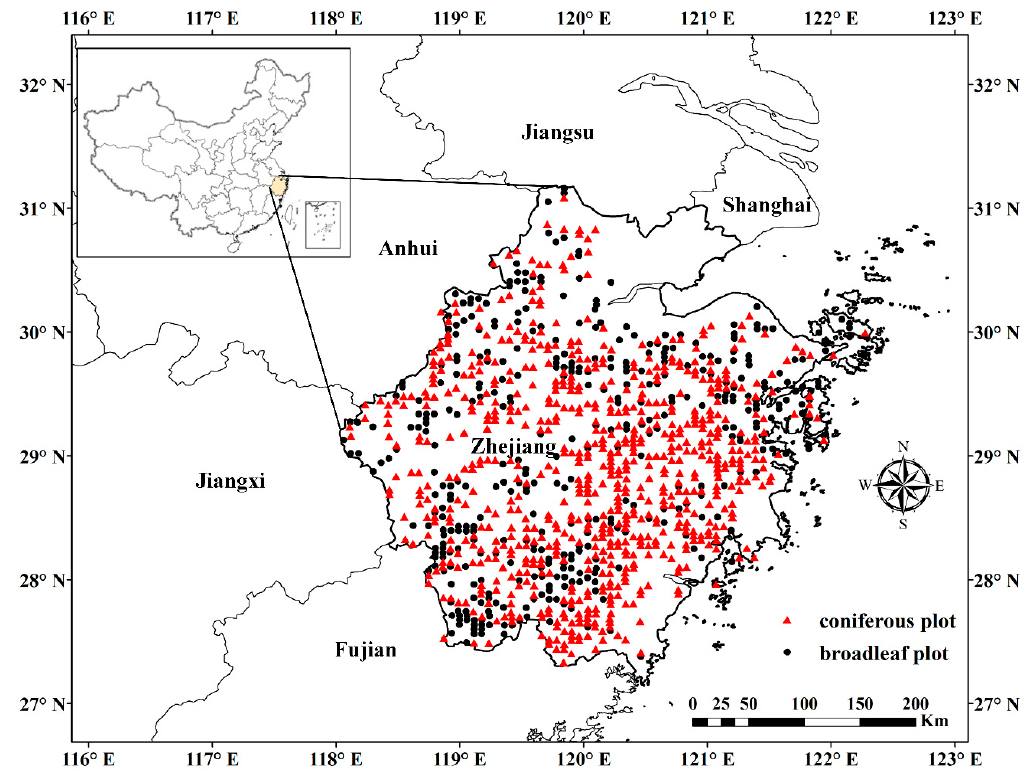
Figure 1. Study area of Zhejiang Province and the location of the forest resource inventory.